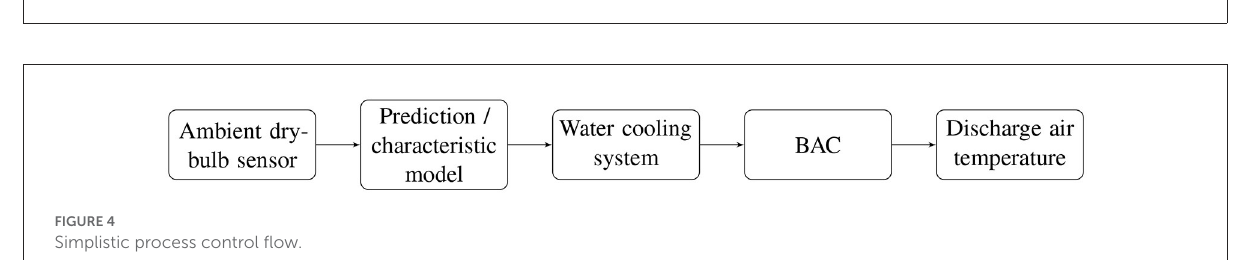
FIGURE4 Simplistic process control flow.